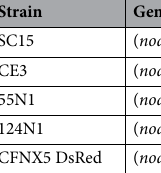
Table 1. Rhizobium etli strains used in this study. a Polymorphic form of the nod C gene according to an ARFLP study (Aguilar et al.,